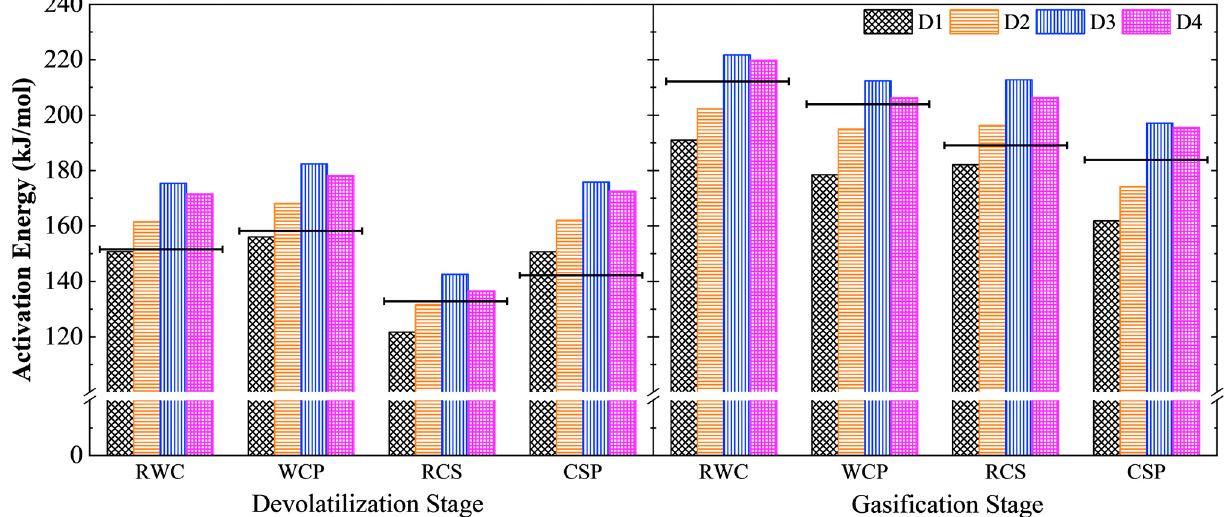
Figure 6. Comparison of activation energy using the Coats–Redfern method with D1, D2, D3 and D4 models (columns) and the DAEM method (average value presented by solid line).